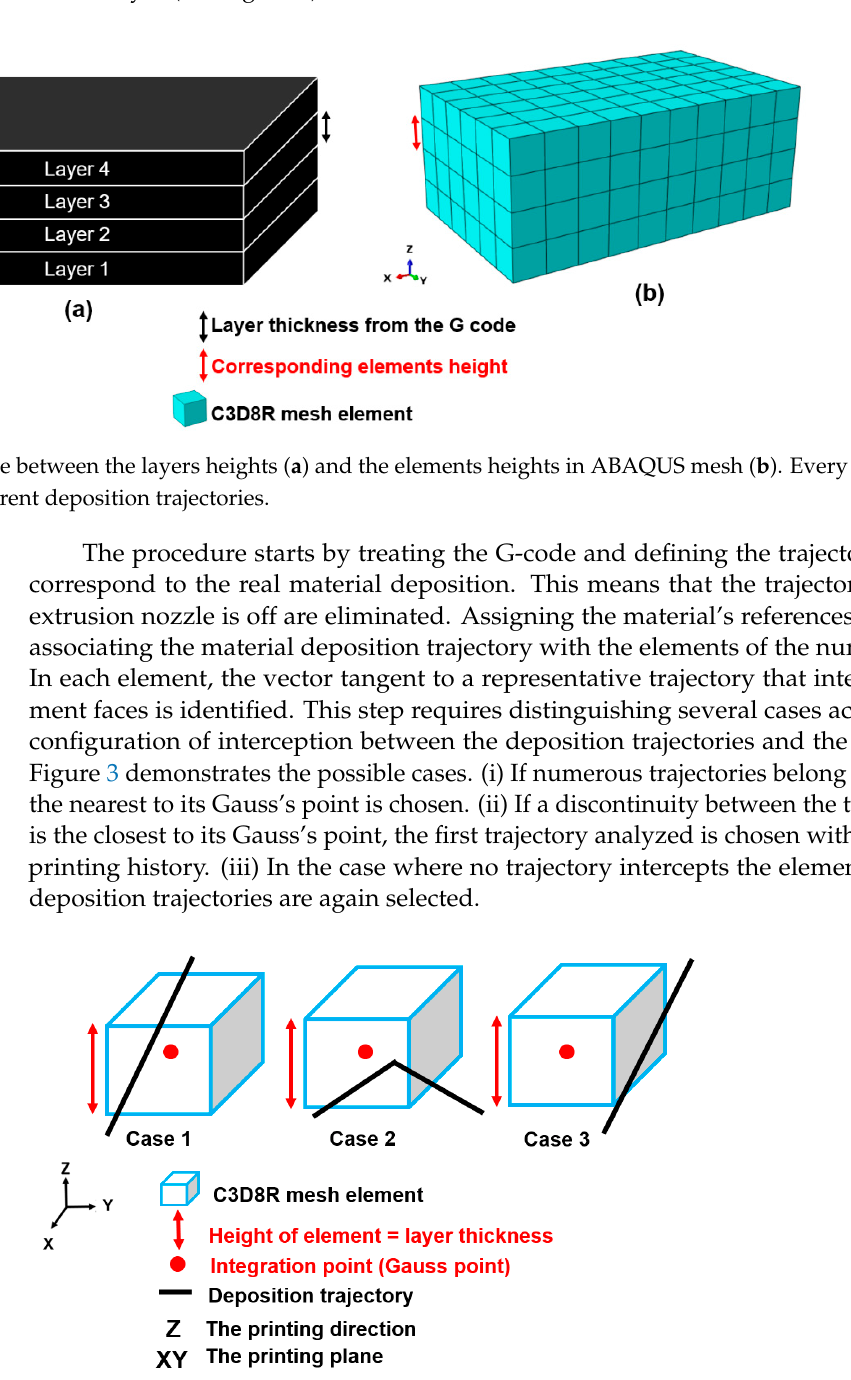
Figure 3. Possible interception cases between one mesh element C3D8R and the deposition trajec- tories .